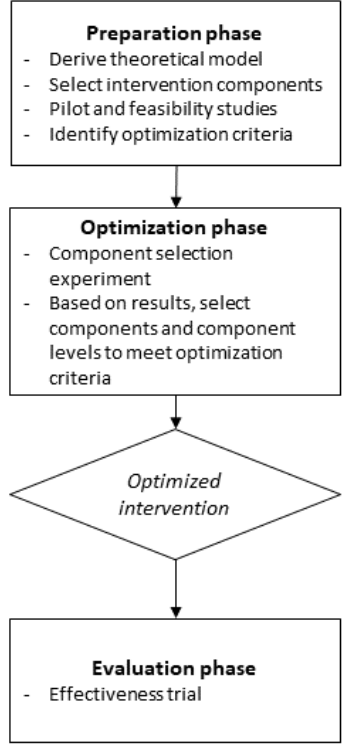
Figure 2. The multiphase optimization strategy study